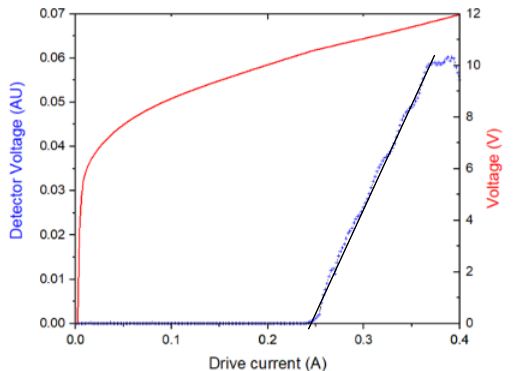
Fig. 5. L-I-V measured (10 o C) at germanium grating via fibre